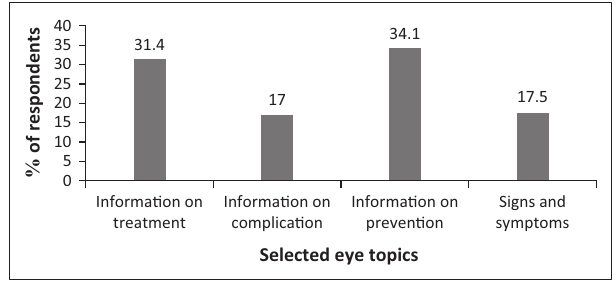
FIGURE 4: Eye health topics selected by participants to receive more information regarding.